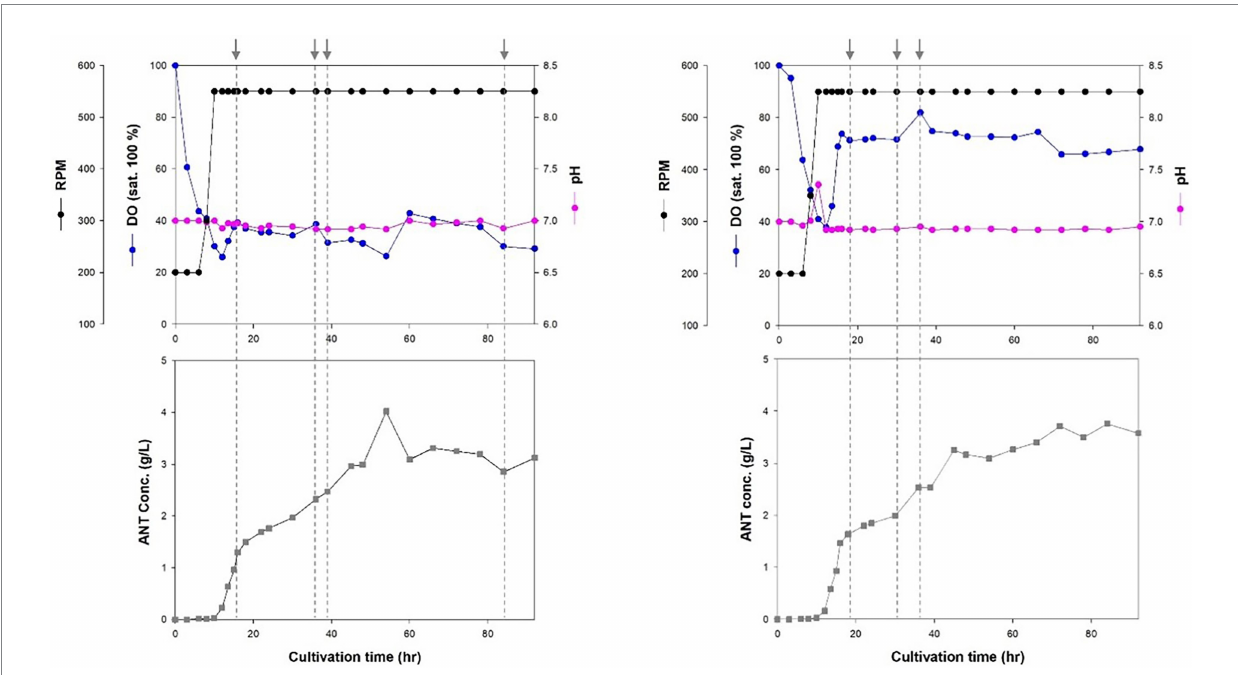
FIGURE 3 Fed-batch fermentation for anthranilate production of Inha256 in a 7 l bioreactor. Time course of RPM, DO concentration, pH and anthranilate production yield were indicated, respectively. The feeding (indicated as an arrow) was started with 0.1323 ml/min at 16 h and changed with 0.1701 ml/ min, 0.1512 ml/min and 0.0567 ml/min at 36, 39, and 84 h, respectively (Left) . The feeding was started with 0.1323 ml/min at 16 h and changed with 0.0945 and 0.1323 ml/min at 30 and 36 h, respectively (Right)